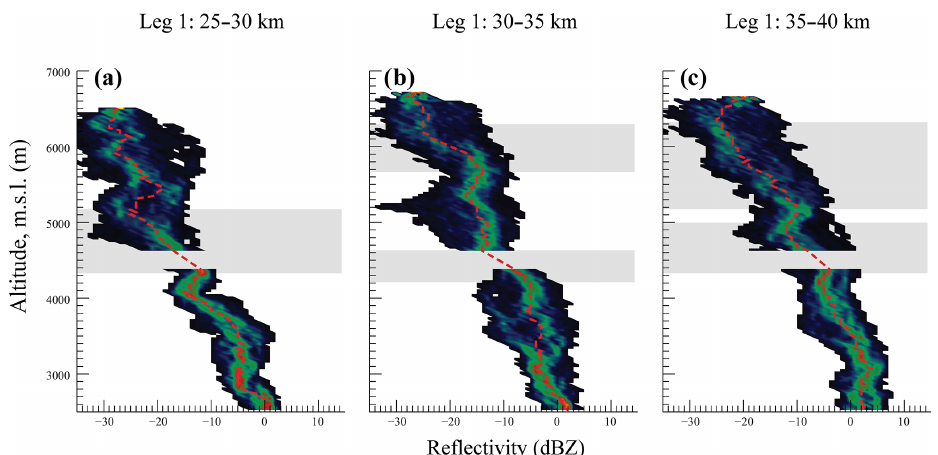
Figure 8. CFAD of radar reflectivity for three 5km wide columns from leg 1, with relative location in km downwind of PJ indicated at the top of each panel. The dashed red line is the median reflectivity for a vertical level, and frequency is normalized for each vertical level (same colors at the top as any other level). Shading indicates the primary inferred-growth regions within the elevated cellular layer.